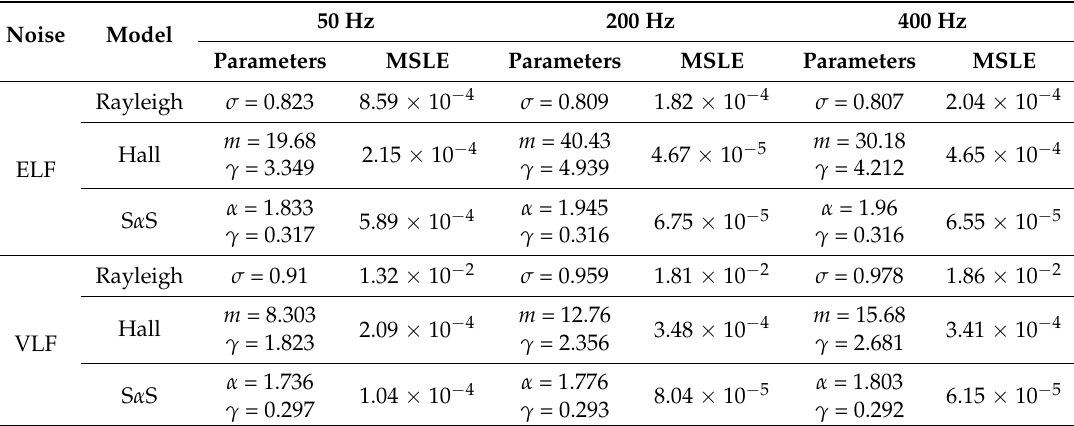
Figure 9. Comparisons of the fitting performance for ( a ) ELF atmospheric noise and ( b ) VLF atmospheric noise. Table 2. Fitting performance for the ELF noise by the two